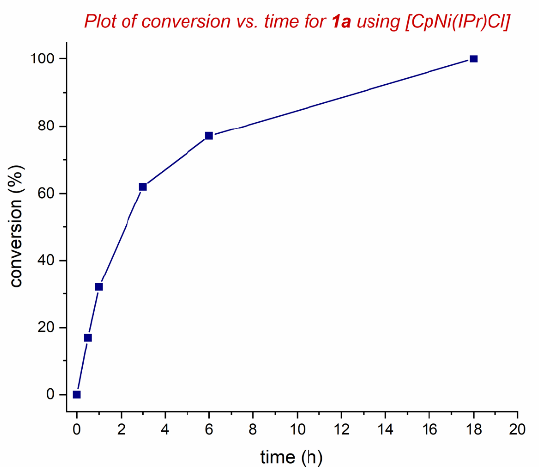
Figure 3. Kinetic profile of 1a . Conditions: 1a , 4-MeO-C 6 H 4 -NH 2 (2.0 equiv), [CpNi(IPr)Cl] (10 mol%), K 2 CO 3 (3.0 equiv), toluene (0.25 M), 140 °C, 0–18